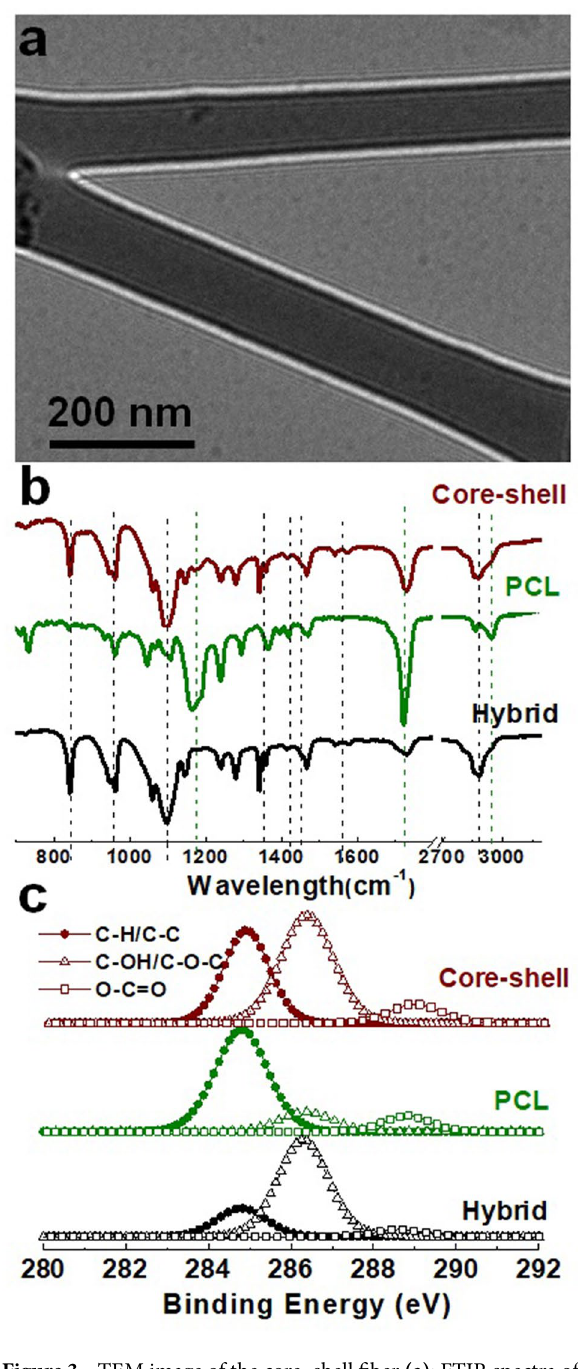
Figure 3. TEM image of the core–shell fiber (a) ; FTIR spectra of the electrospun scafflds (b) , and deconvolved XPS spectra of carbon in the scaffolds (c) . Overall results suggests that the shell layer was much thinner compared to the core layer in the resulted core–shell